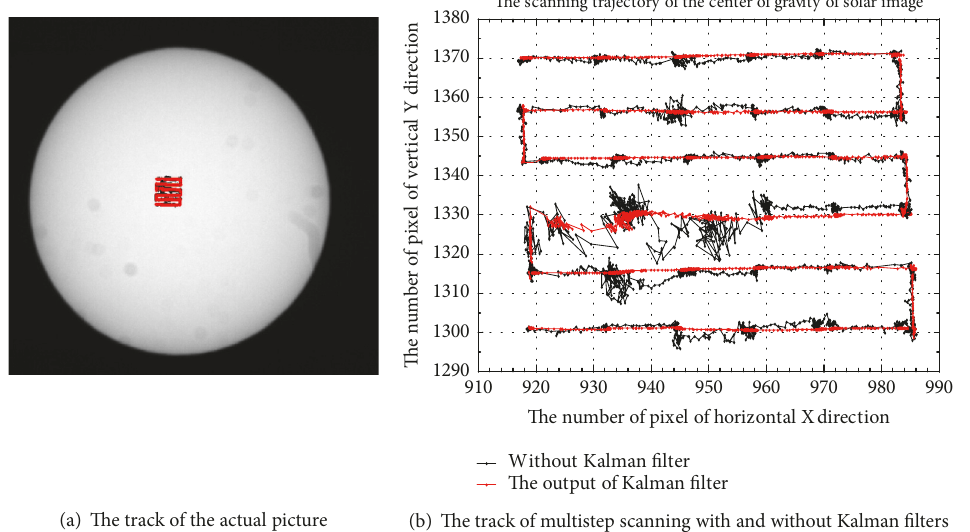
Figure 9: The comparison of the track of the center of gravity of full-disk solar image.